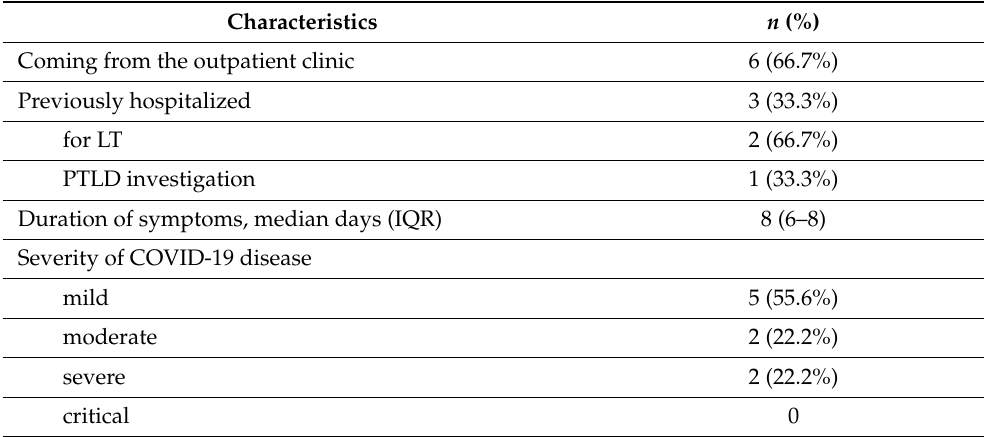
Table 4. Clinical course and outcomes of 9 hospitalized PLTR with COVID-19